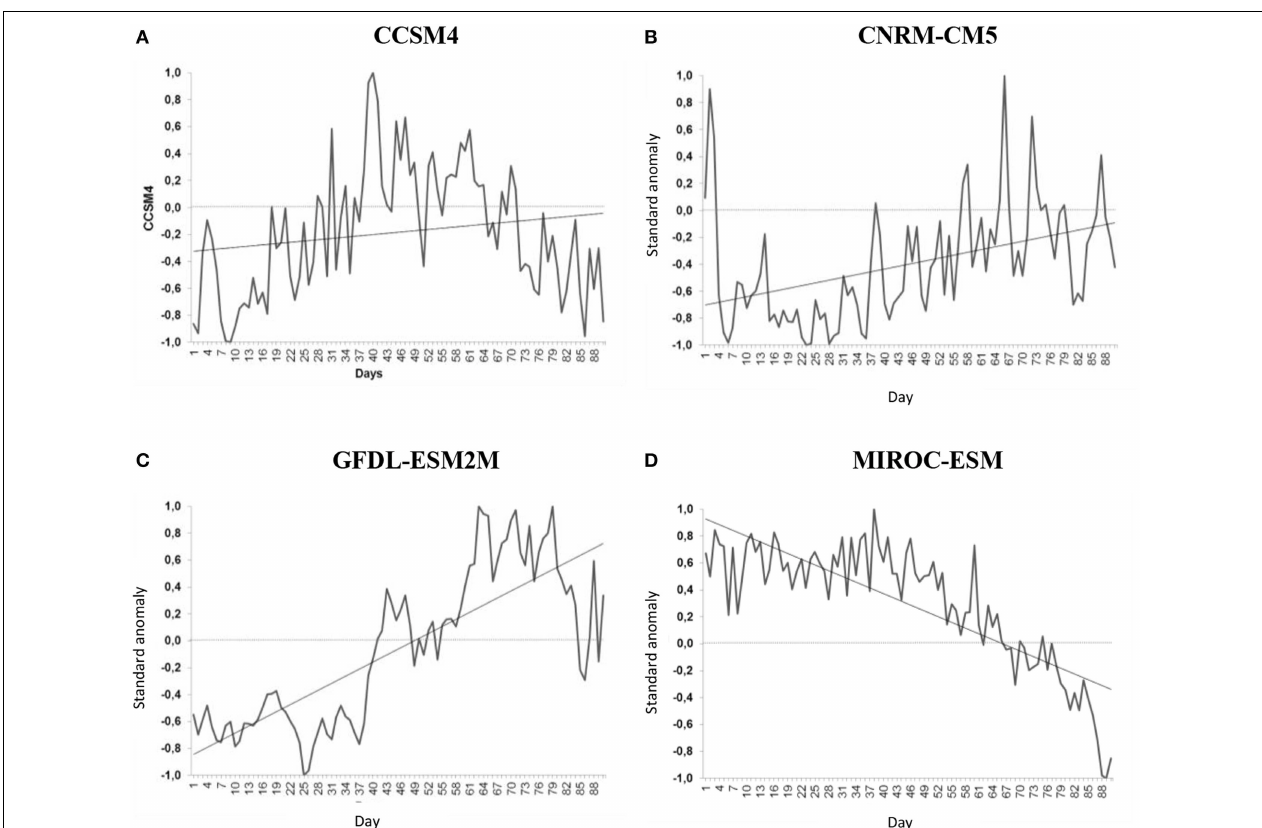
FIGURE 12 | Projections of the daily precipitation on the future climate during FMA season of 2055–2095 period over the north of the NEB simulated by the CMIP5 models: (A) CCSM4, (B) CNRM_CM5, (C) GFDL_ESM2M, (D) MIROC_ESM.